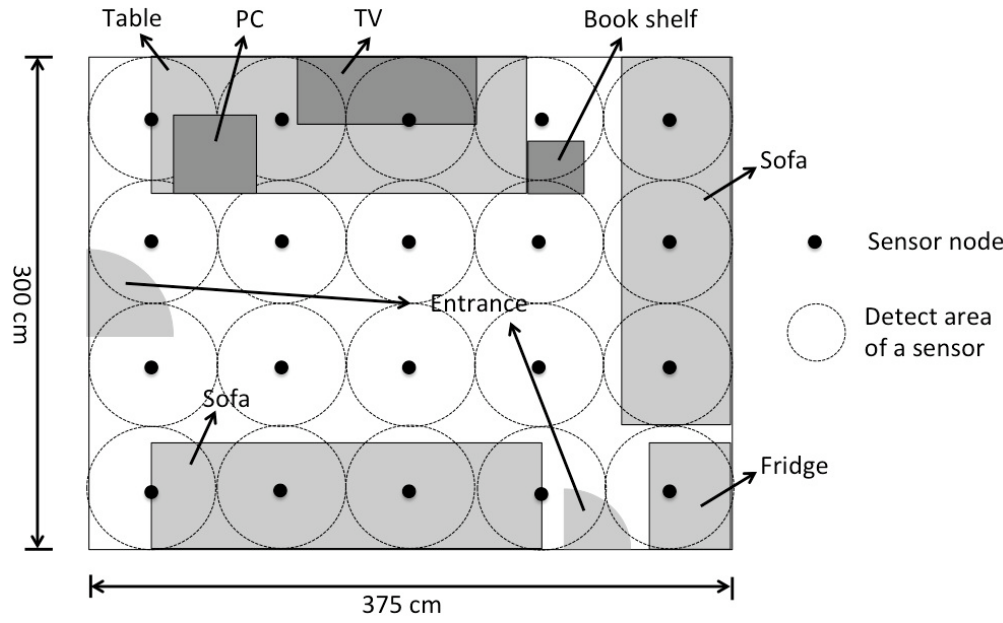
Figure 3. Layout of the home environment and the infrared sensors (top